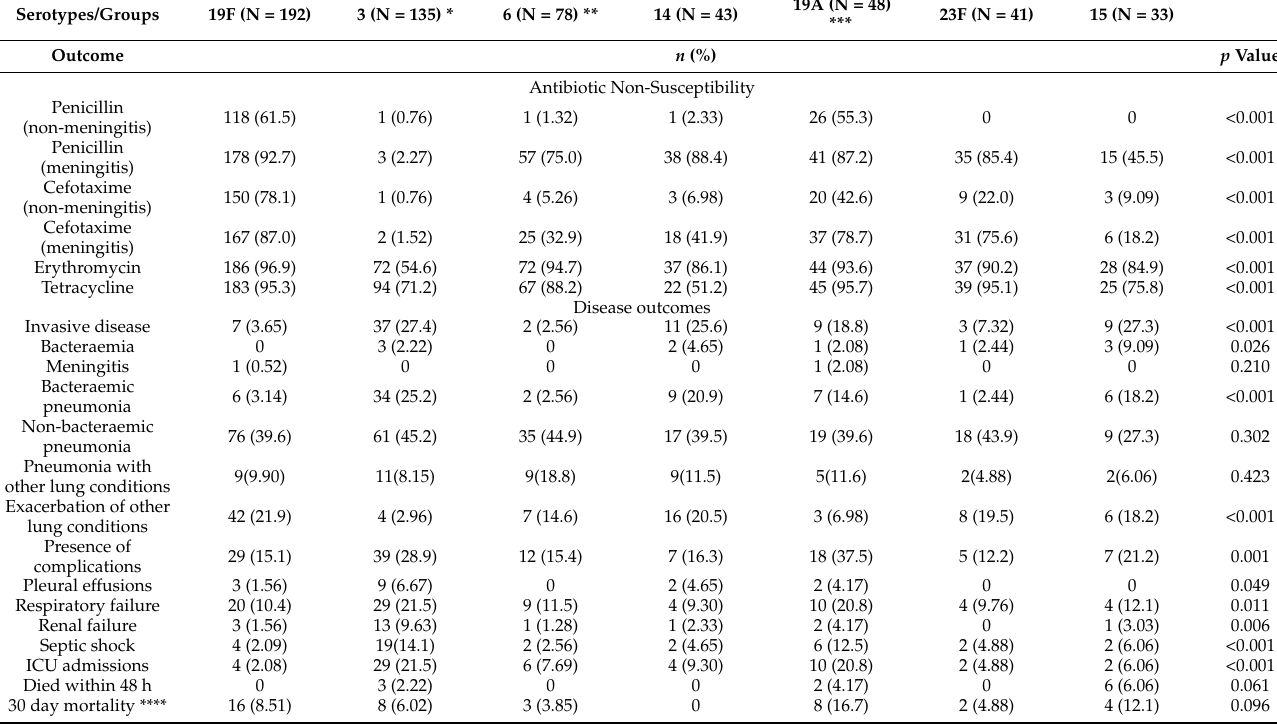
Table 6. Association between common serotypes/groups with antimicrobial non-susceptibilities and disease outcomes. Serotypes/Groups